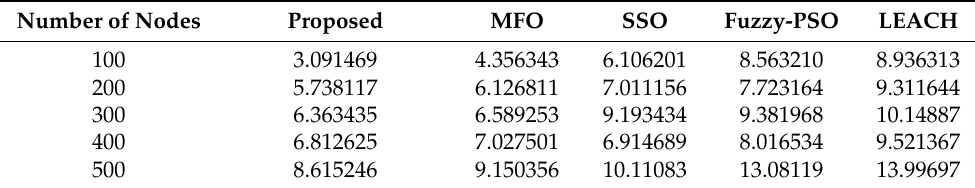
Figure 4. Analysis of throughput vs. number of nodes. Table 5. End-to-end delay comparison with different routing protocols. Table 5. End-to-end delay comparison with different routing protocols.